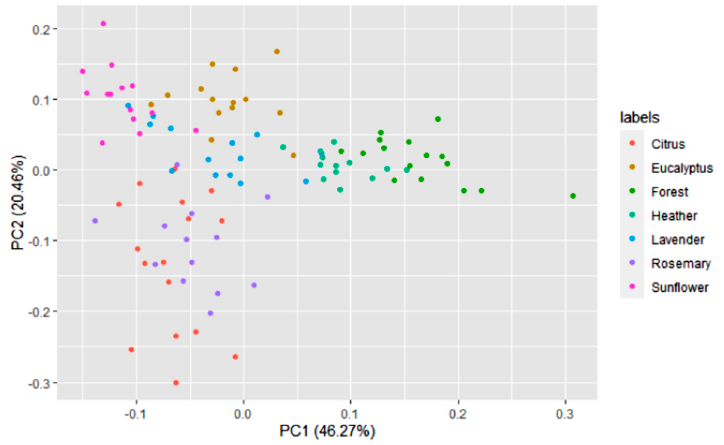
Figure 2. Principal component score plot based on the 14 variables of 100 honey samples according to the botanical origins.